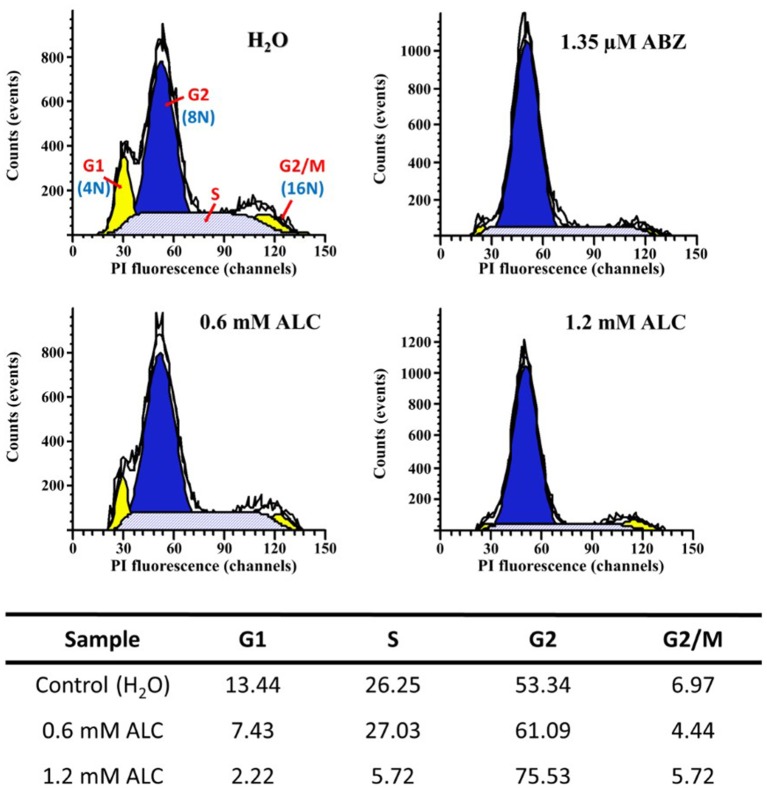
Allicin partially arrests G. duodenalis trophozoites at G2 phase. Parasites (1 × 106) were exposed to 1.0% double distilled water pH 6.5 (Control) or the indicated concentrations of ABZ (positive control for cell cycle arrest) or ALC for 24 h at 37°C. Nuclei of permeabilised and RNAse A-treated cells were stained with PI and processed by flow cytometry. The areas under curve (AUC) corresponding to G1, S, G2, or G2/M cell cycle phases are indicated in the control histogram. Percentages of cells within each AUC are shown in the table at the bottom of histograms. Data are representative of two independent experiments.